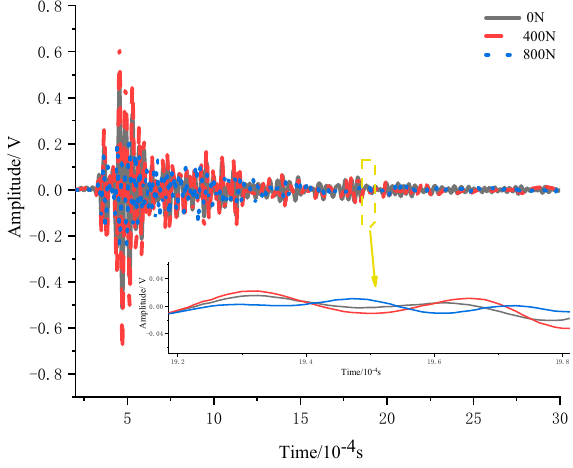
Figure 12. Receiving waveforms in different loading states.